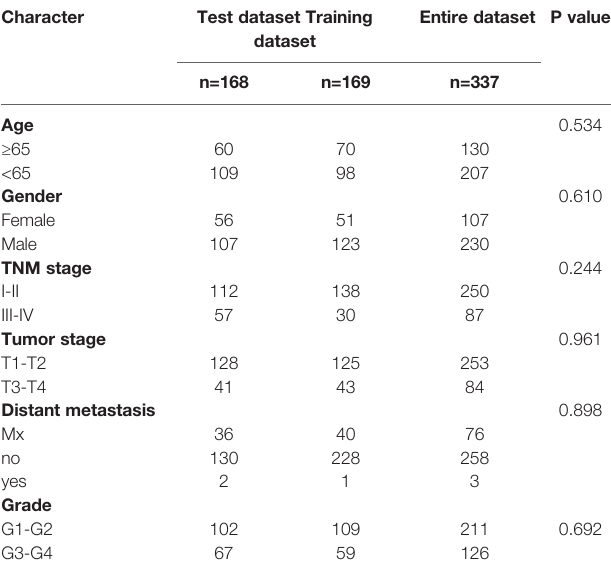
TABLE 1 | Clinical characteristics of 337 patients with hepatocellular carcinoma. Character Test dataset Training